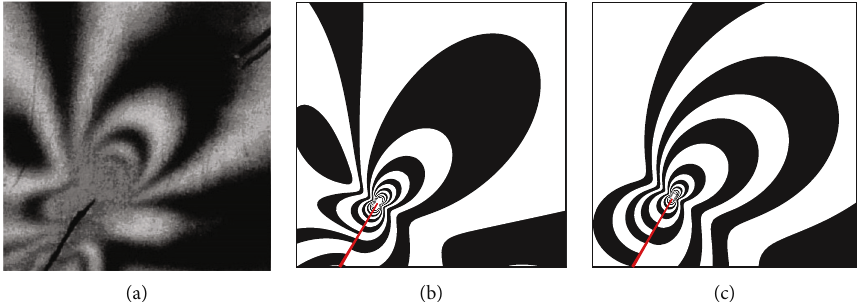
Figure 15: The comparison of isochromatic fringe patterns at crack tip obtained from experiment and models: (a) experimental results [38]; (b) the results of proposed model; and (c) the results of Fan ’ s model